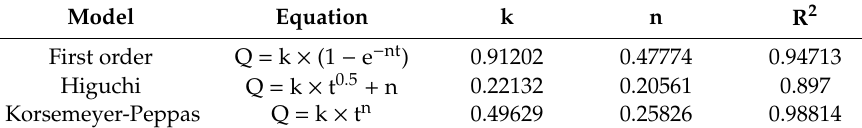
Table 5. The models of release behavior and parameters of fitted curves.